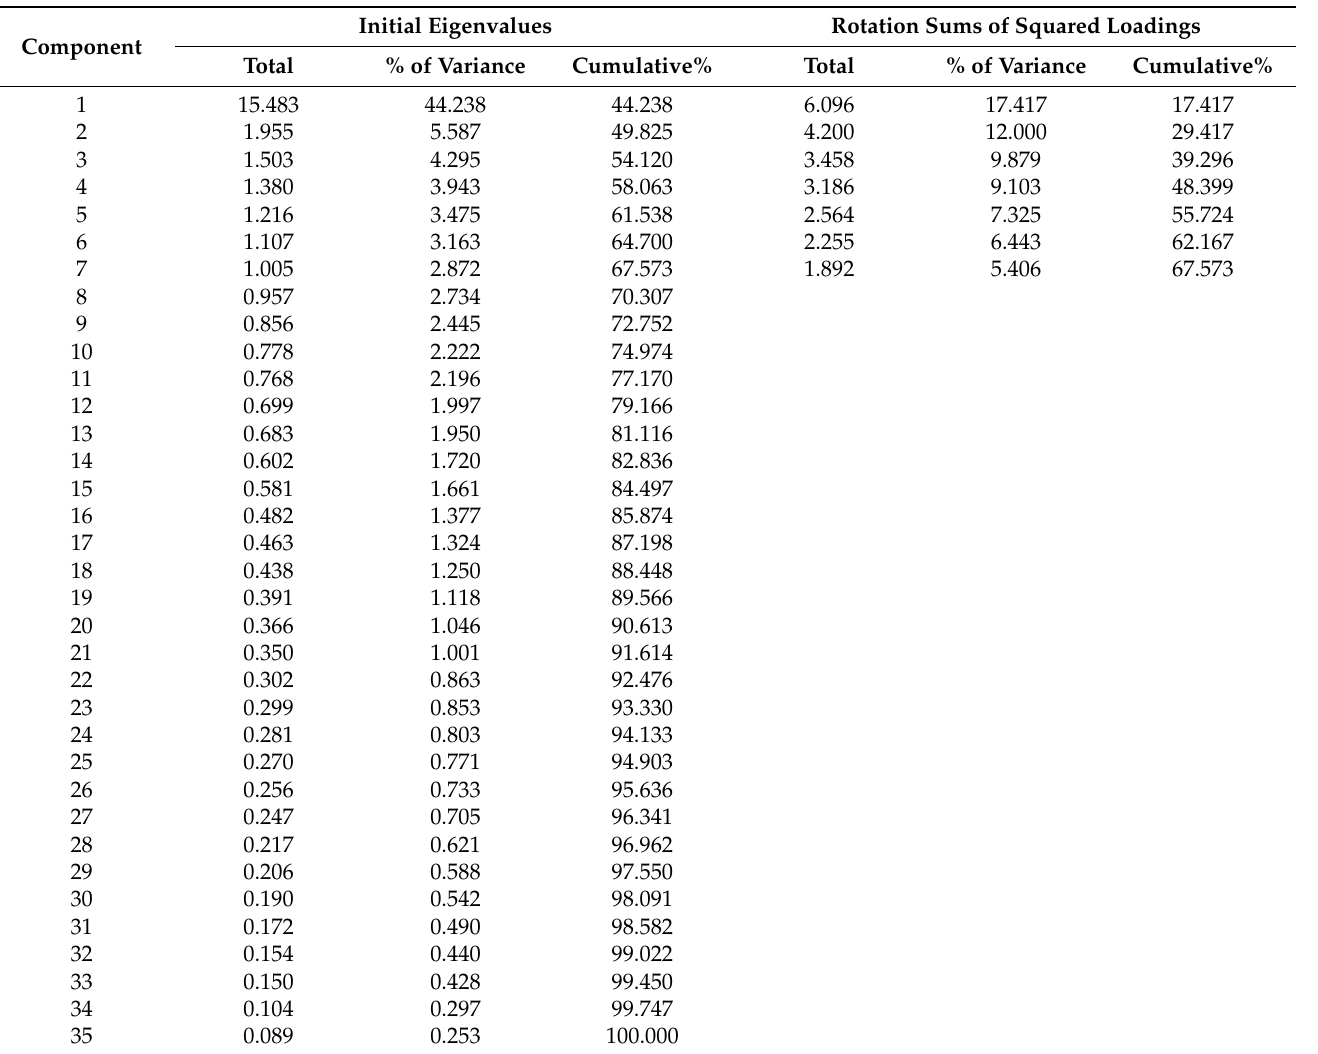
Table 4. Total variance explained for the major barriers to the adoption of BIM technology in the construction